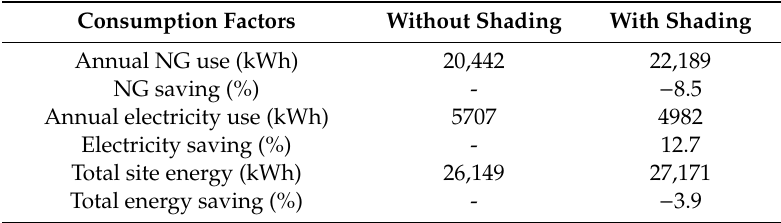
Table 11. The annual energy consumption and energy saving for the building with and without shading. Consumption Factors